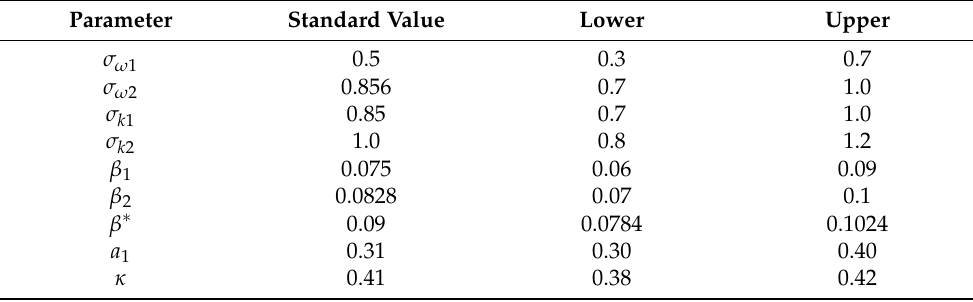
Table 1. Standard values of parameters in the SST model with uncertainty